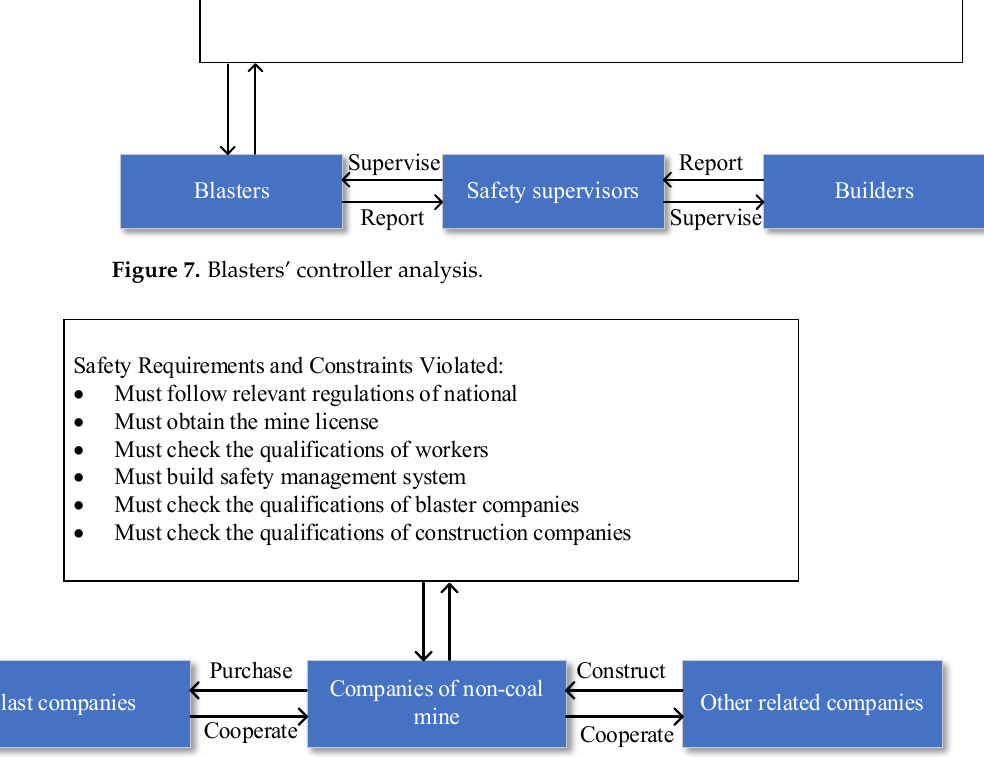
Figure 7. Blasters’ controller analysis.